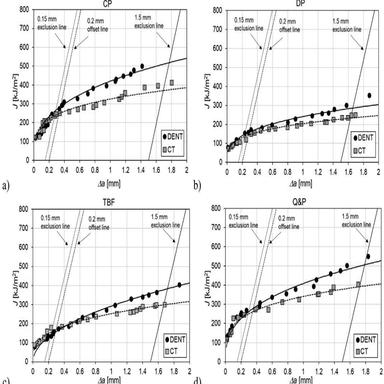
J-R curves for the investigated AHSS grades: (a) CP, (b) DP, (c) TBF and (d) Q&P.